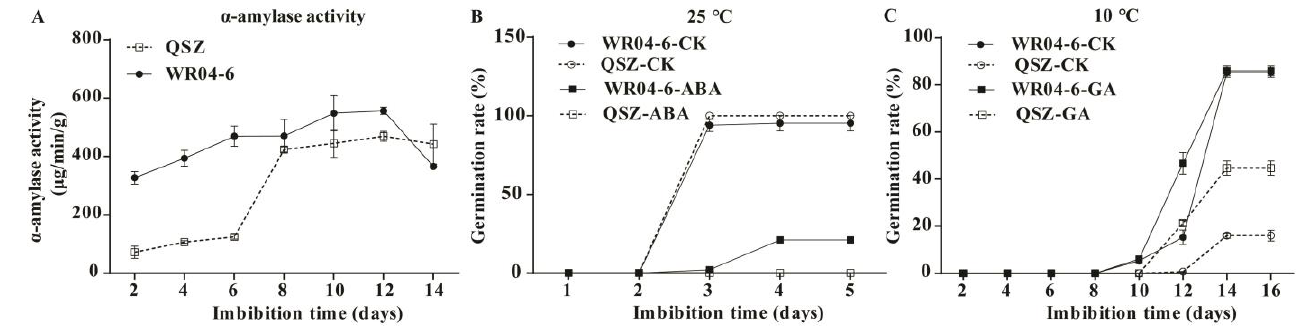
Figure 5. LTG-related index detection. ( A ) Time course of α -amylase activity of WR04-6 and QSZ germinated at 10 °C. ( B ) Germination behavior of WR04-6 and QSZ under 10 μM ABA treatment at 25 °C. ( C ) Germination behavior of WR04-6 and QSZ under 10 μM GA treatment at 10 °C. Error bars indicate SD ( n = 3).